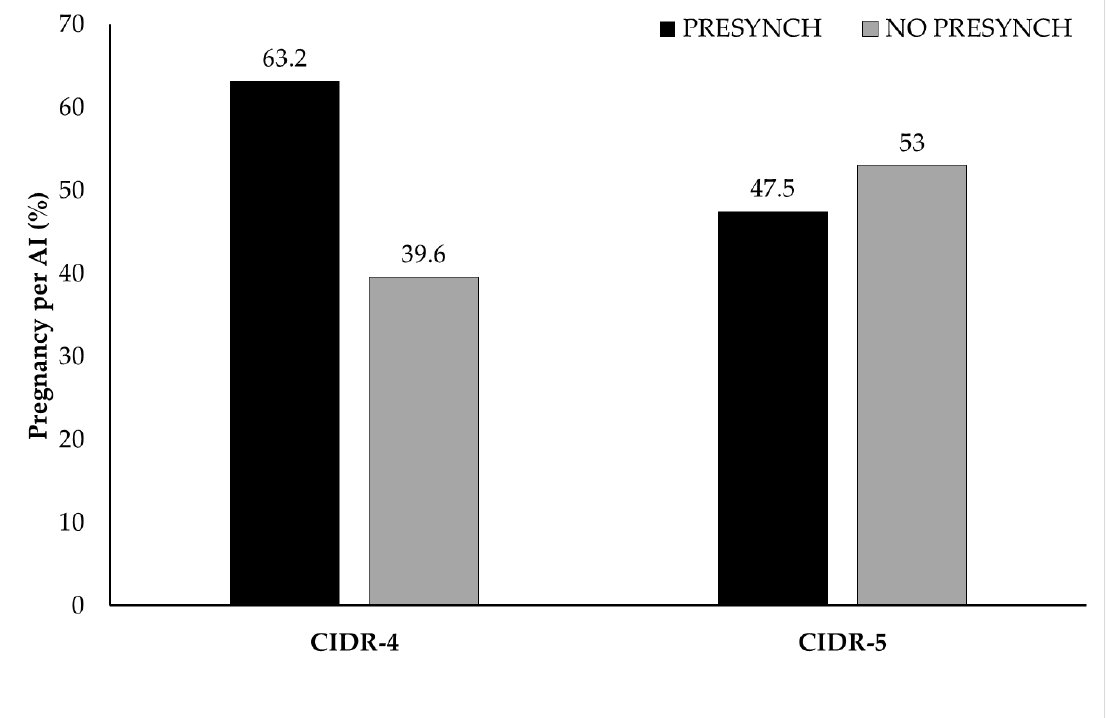
Figure 5. Significant ( p < 0.05) interaction effect of treatment (CIDR-4 vs. CIDR-5) by presynchronization indicates lower pregnancy per AI in heifers without presynchronization (gray bars) compared to those with presynchronization (black bars) in CIDR-4 group. While pregnancy per AI in heifers with or without presynchronization were similar in CIDR-5